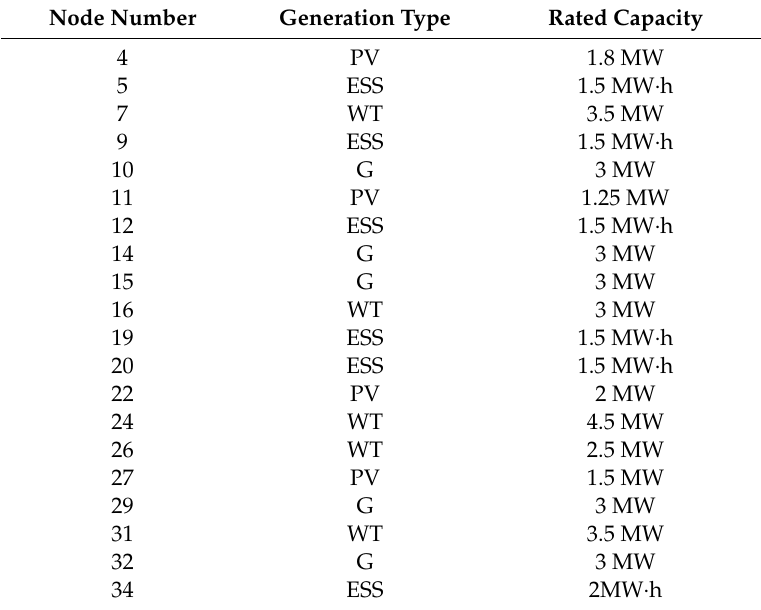
Table 1. The capacity parameter of distributed energy resources (DER) unit.